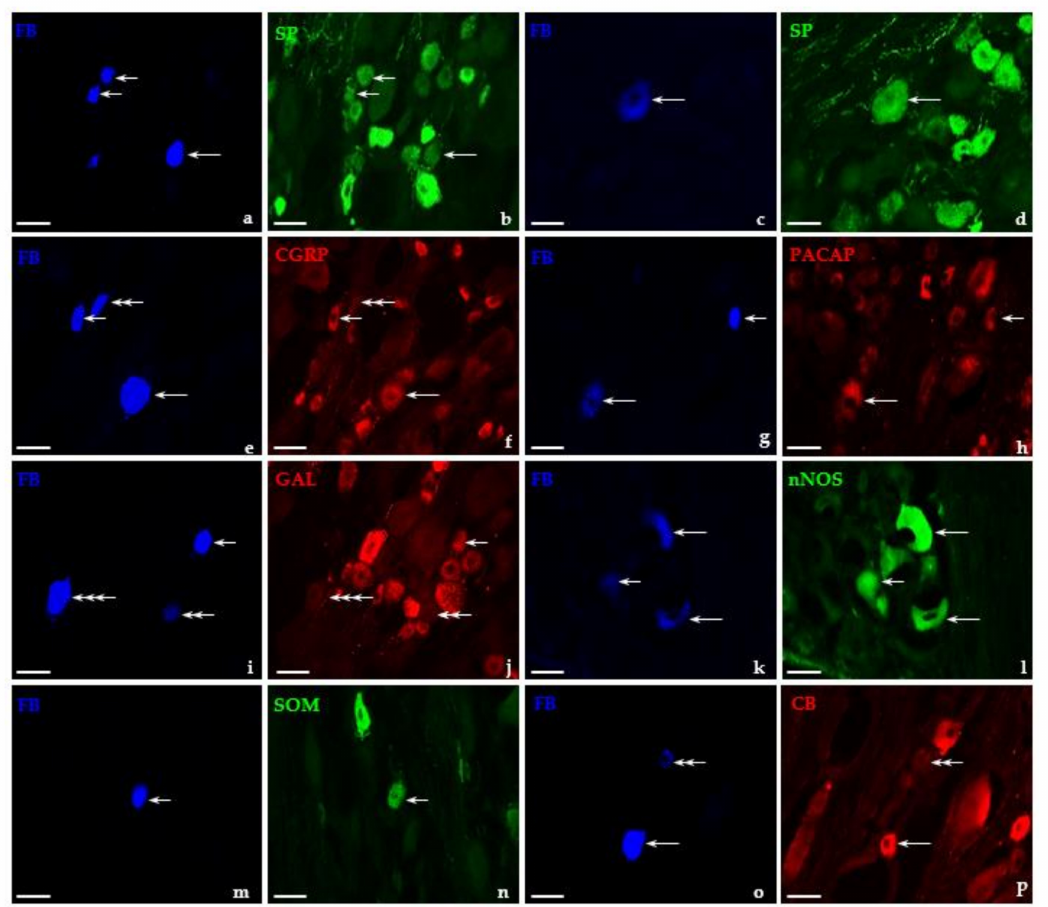
Figure 4. Representative images of DRG-UB-PNs in the control pigs. All the images were taken separately from blue ( a,c,e,g,i,k,m,o ), green ( b,d,l,n ), and red ( f,h,j,p ) fluorescent channels. Short arrows represent small-sized FB-positive DRG-UB-PNs ( a,e,g,i,k,m ) which were simultaneously substance P- (SP; b ), calcitonin gene-related peptide- (CGRP; f ), pituitary adenylate cyclase-activating polypeptide- (PACAP; h ), galanin- (GAL; j ), neuronal nitric oxide synthase- (nNOS; l ) or somatostatin-positive (SOM; n ). Long arrows represent middle-sized FB-positive DRG-UB-PNs ( a,c,e,g,k,o ) that simultaneously contained SP ( b ), CGRP ( f ), PACAP ( h ), nNOS ( l ), or calbindin (CB; p ). Double arrows represent small-sized FB-positive DRG-UB-PNs ( e,i,o ), which were simultaneously CGRP- ( f ), GAL- ( j ), or CB-negative ( p ). Triple arrows represent middle-sized FB-positive DRG-UB-PN ( i ), which was simultaneously GAL-negative ( f ). Bar in all the images—50 µ